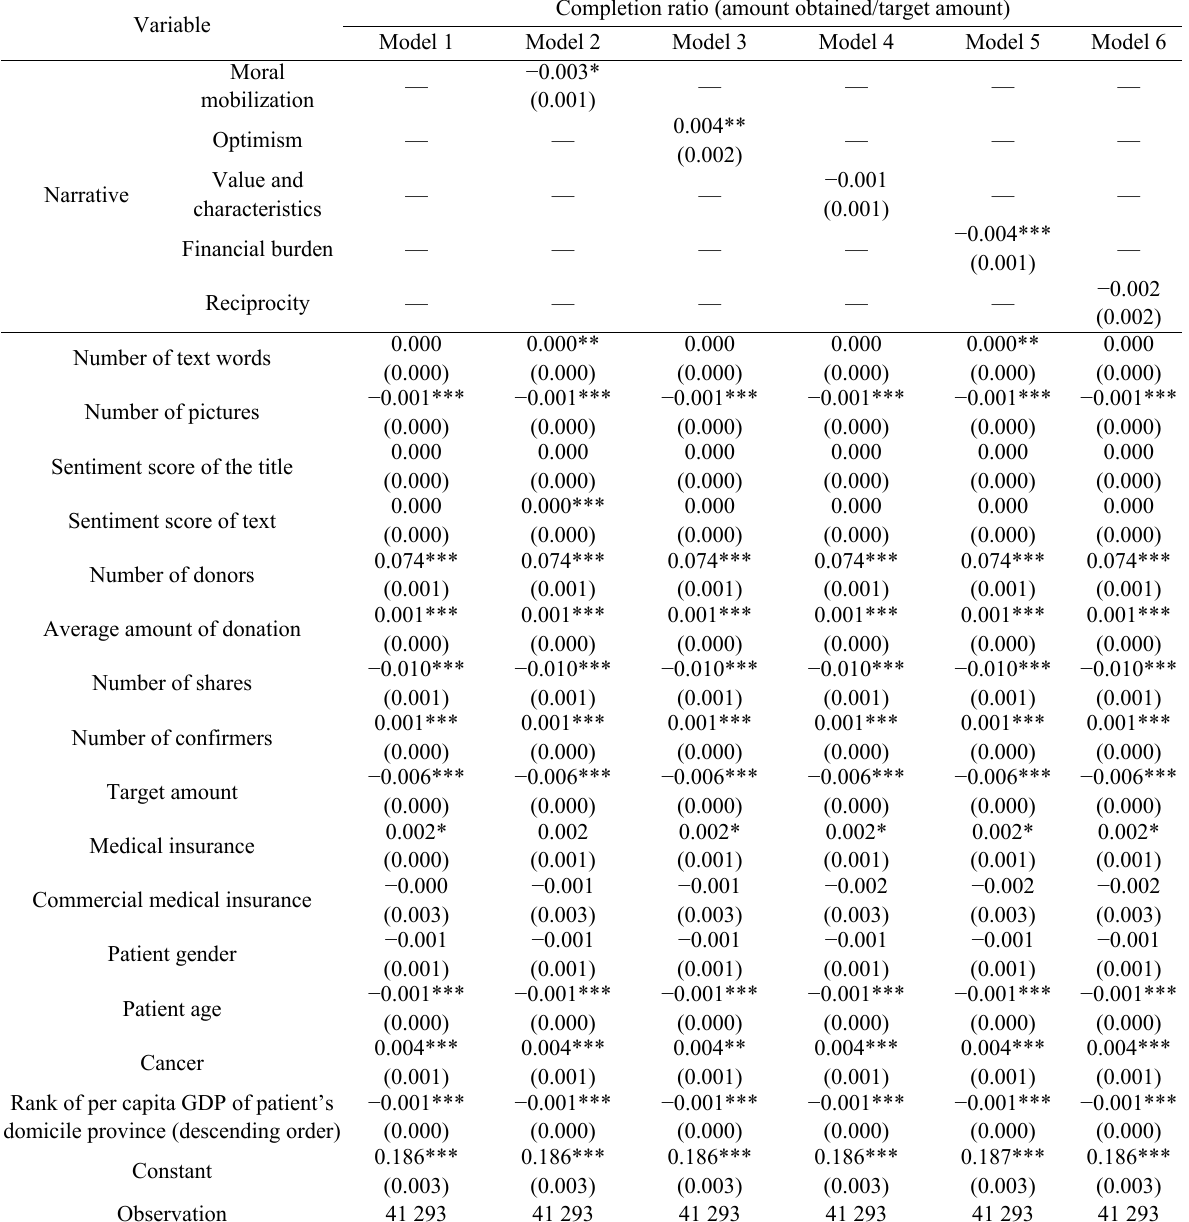
Table 6 Effects of narrative strategies on completion